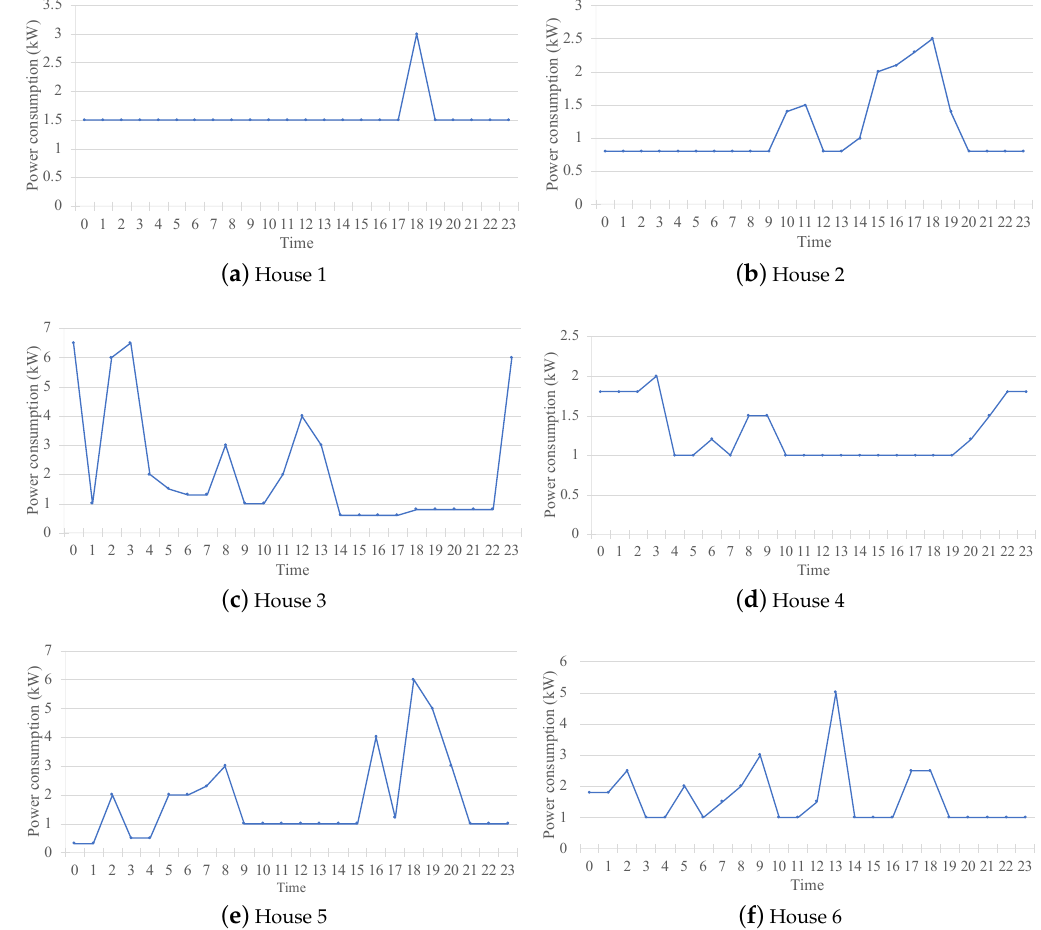
Figure 16. Practical case with the consumption of six loads in IEEE14 bus.